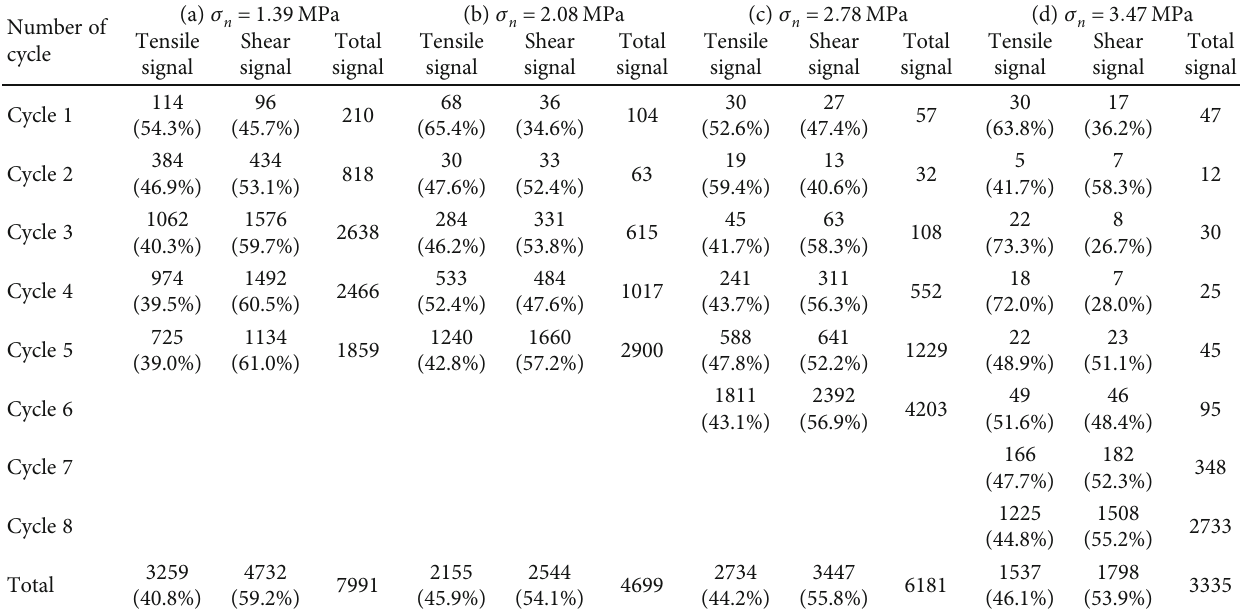
Table 3: Statistical distribution results of tensile and shear signals in each